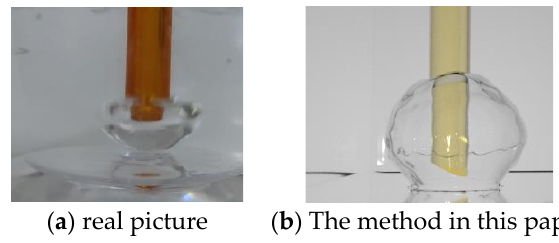
Figure 8. Comparison of the effectiveness of the bubble model. The bubble in the water is super bright because it is surrounded by a circle of total internal reflection (TIR) with a perfect reflection. The rendering of bubbles in water should be achieved by assigning the bubble geometry higher priority than water and the straw index of refraction inside the bubble. Thus, the refraction effect of light at different bound- aries between air, liquid, and glass can be correctly reflected. The experiment demonstrates that our method provides a visually credible bubble effect in water.